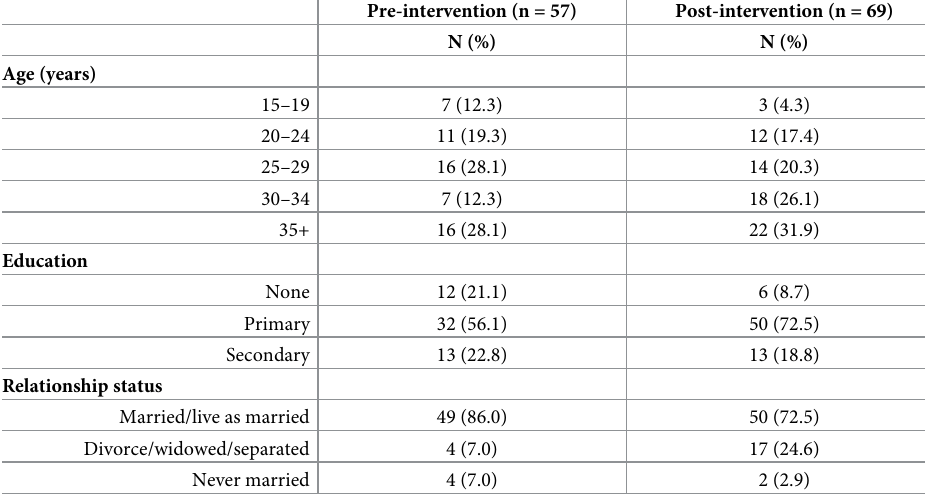
Table 6. Characteristics of participants in PMTCT FGDs, pre- and post-